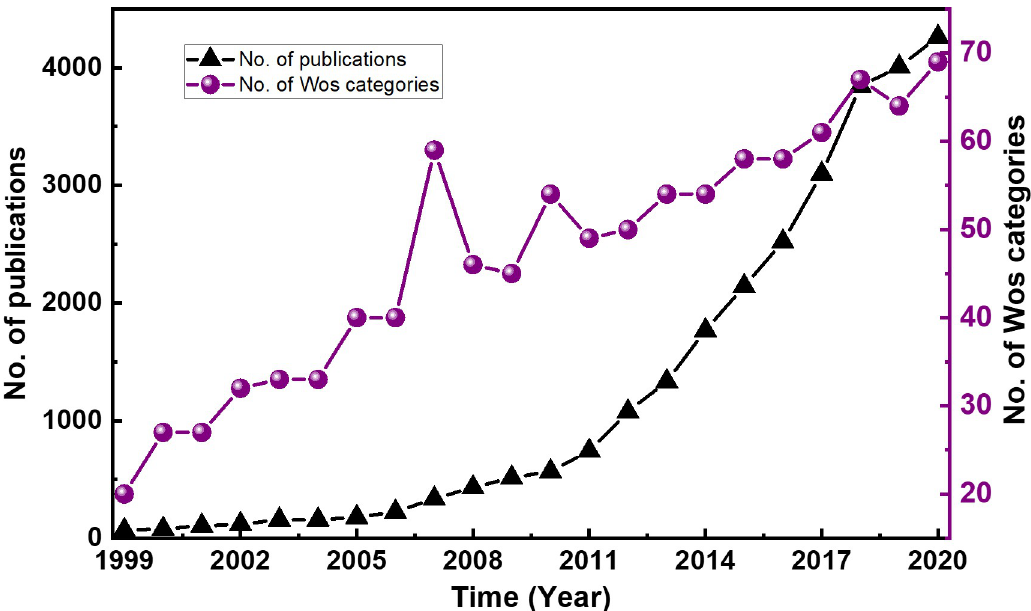
Fig 1. Distributions of the publication years in photocatalytic research. The black line represents the number of published studies, and the purple line represents the number of WoS subject categories.